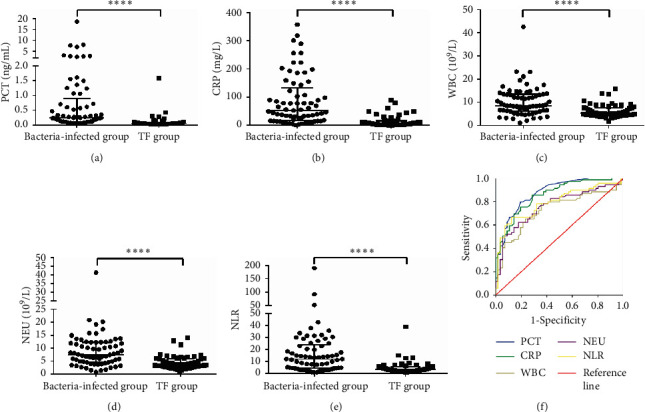
Inflammatory markers (PCT, CRP, WBC, NEU, and NLR) between bacteria-infected subgroup A (N = 69) and TF subgroup A (N = 56) in febrile NNLCPs. The differences of PCT (a), CRP (b), WBC (c) and NEU (d) levels, and NLR (e) between bacteria-infected subgroup A (N = 69) and TF subgroup A (N = 56). The horizontal lines represented the median. Statistical significance was calculated with Mann–Whitney test. (f) ROC curves analysis for PCT, CRP, WBC, NEU, and NLR in subgroup A of NNLCPs. ∗∗∗∗p < 0.0001; PCT: procalcitonin; CRP: C-reactive protein; WBC: white blood cell; NEU: neutrophil; NLR: neutrophil-to-lymphocyte ratio; TF: tumor fever; AUC: area under the ROC curve; NNLCPs: nonneutropenic lung cancer patients.